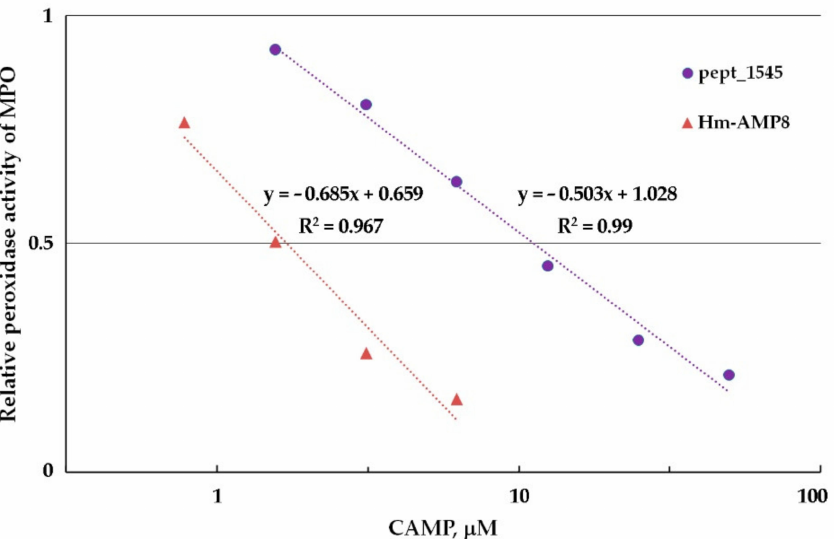
Figure 6. Graphical plot for determination of the half-inhibition concentration (IC 50 ) of pept_1545 and Hm-AMP8 for MPO peroxidase activity. The concentrations were as follows: 8 nM MPO heme, 50 µ M Amplex Red, and 25 µ M H 2 O 2 in 50 mM K-phosphate buffer, pH 7.4. To identify the type of inhibition and to estimate K i , the kinetic data for MPO-catalyzed oxidation of Amplex Red in the presence of CAMPs were analyzed using the Hanes–Woolf linearizations (Figures 7 and 8). The results of the inhibition analysis are presented in Table 3.